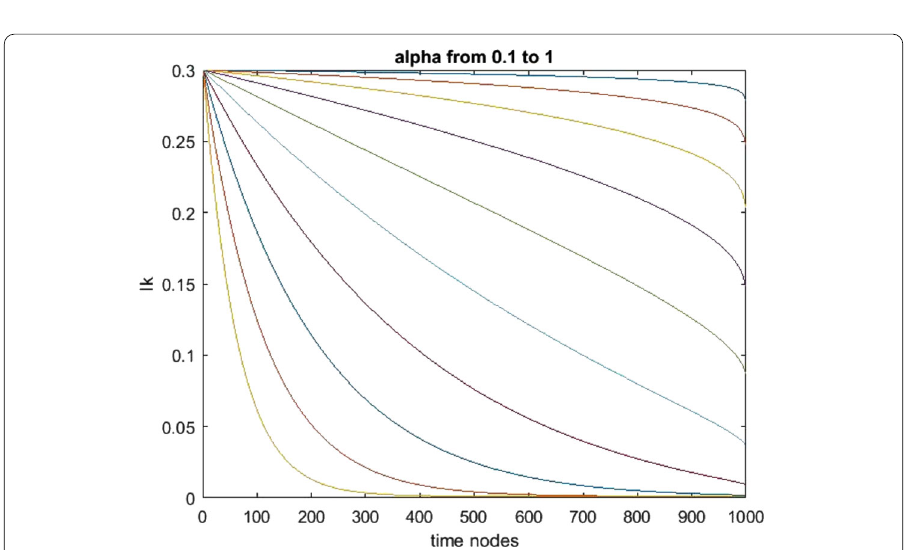
Figure 4 The influence of parameter α on the decay rate when k = 20